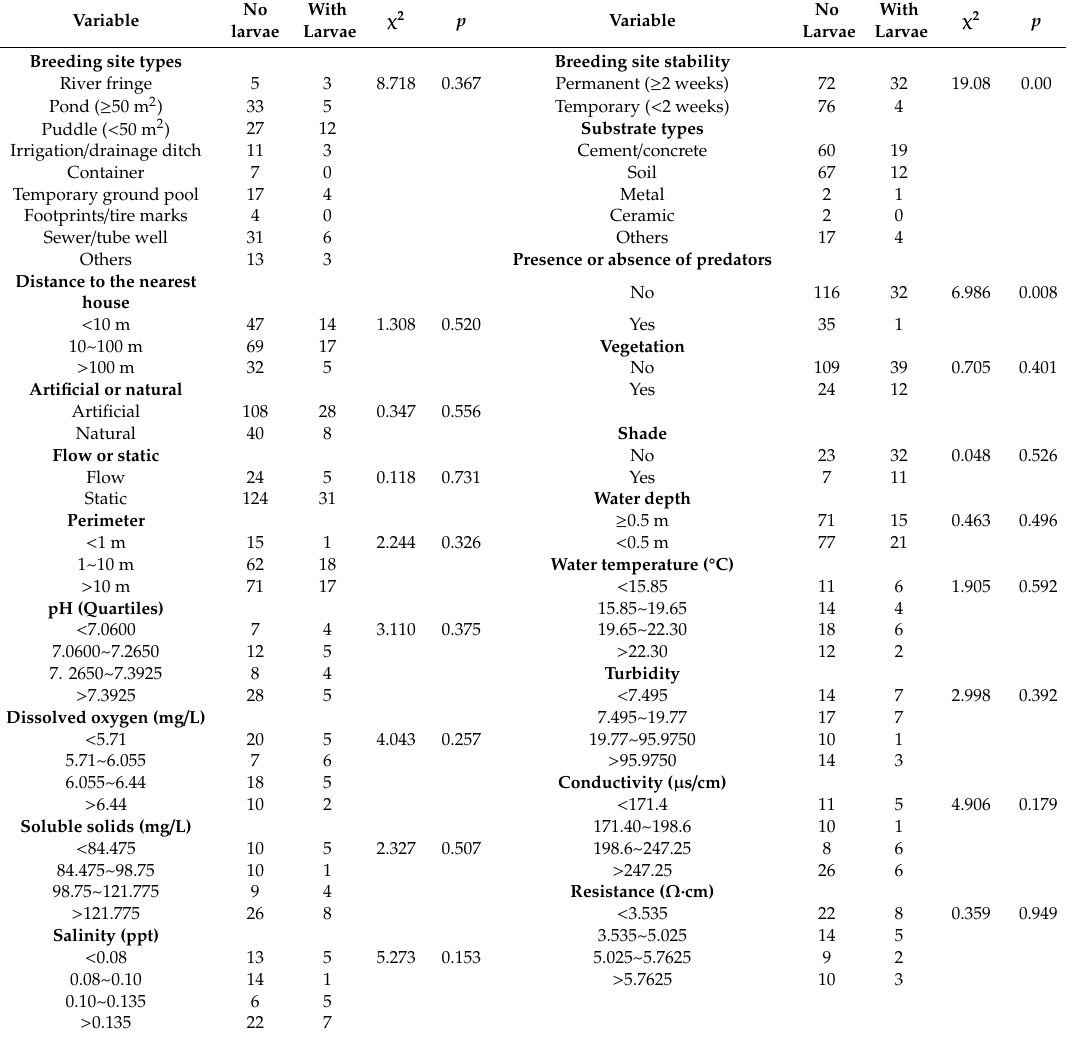
Table 3. Positive parameters determining the presence of Culex pipiens complex larvae in water bodies in Lhasa by chi-square analysis.